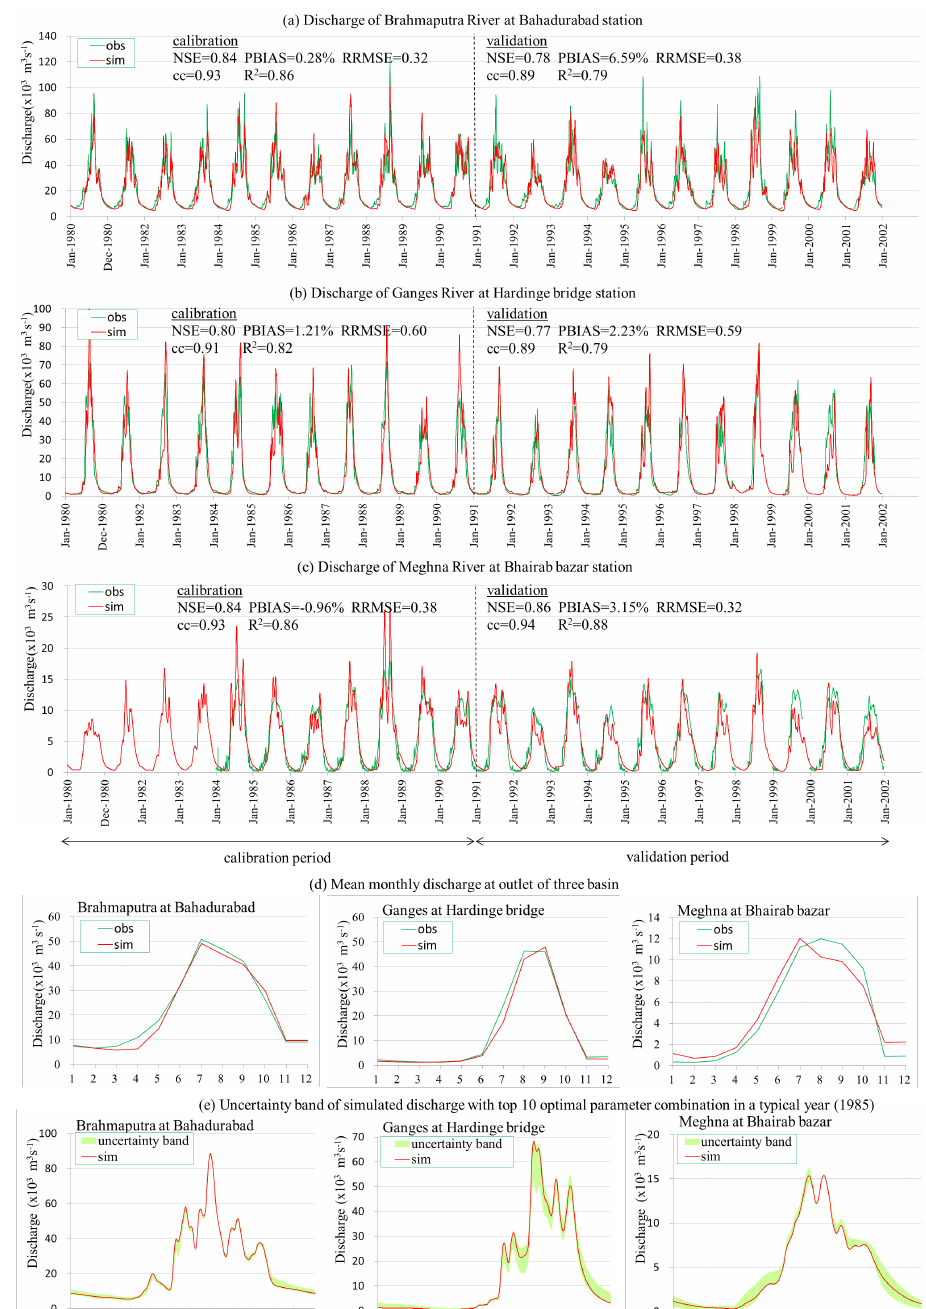
Figure 4. The simulated discharges (red line) using the WFD forcing data (both calibration and validation period) compared with observations (green line) at outlets of the (a) Brahmaputra, (b) Ganges, and (c) Meghna rivers, (d) mean monthly (1980–2001) simulated discharges compared with those of observations at outlets; (e) simulated discharges by using the 10 optimal parameter sets (red line) and the associated uncertainty bands (green shading) in a typical year (1985). NSE, PBIAS, RRMSE, cc and R 2 for both calibration and validation periods are noted at subplots (a) , (b) and (c)